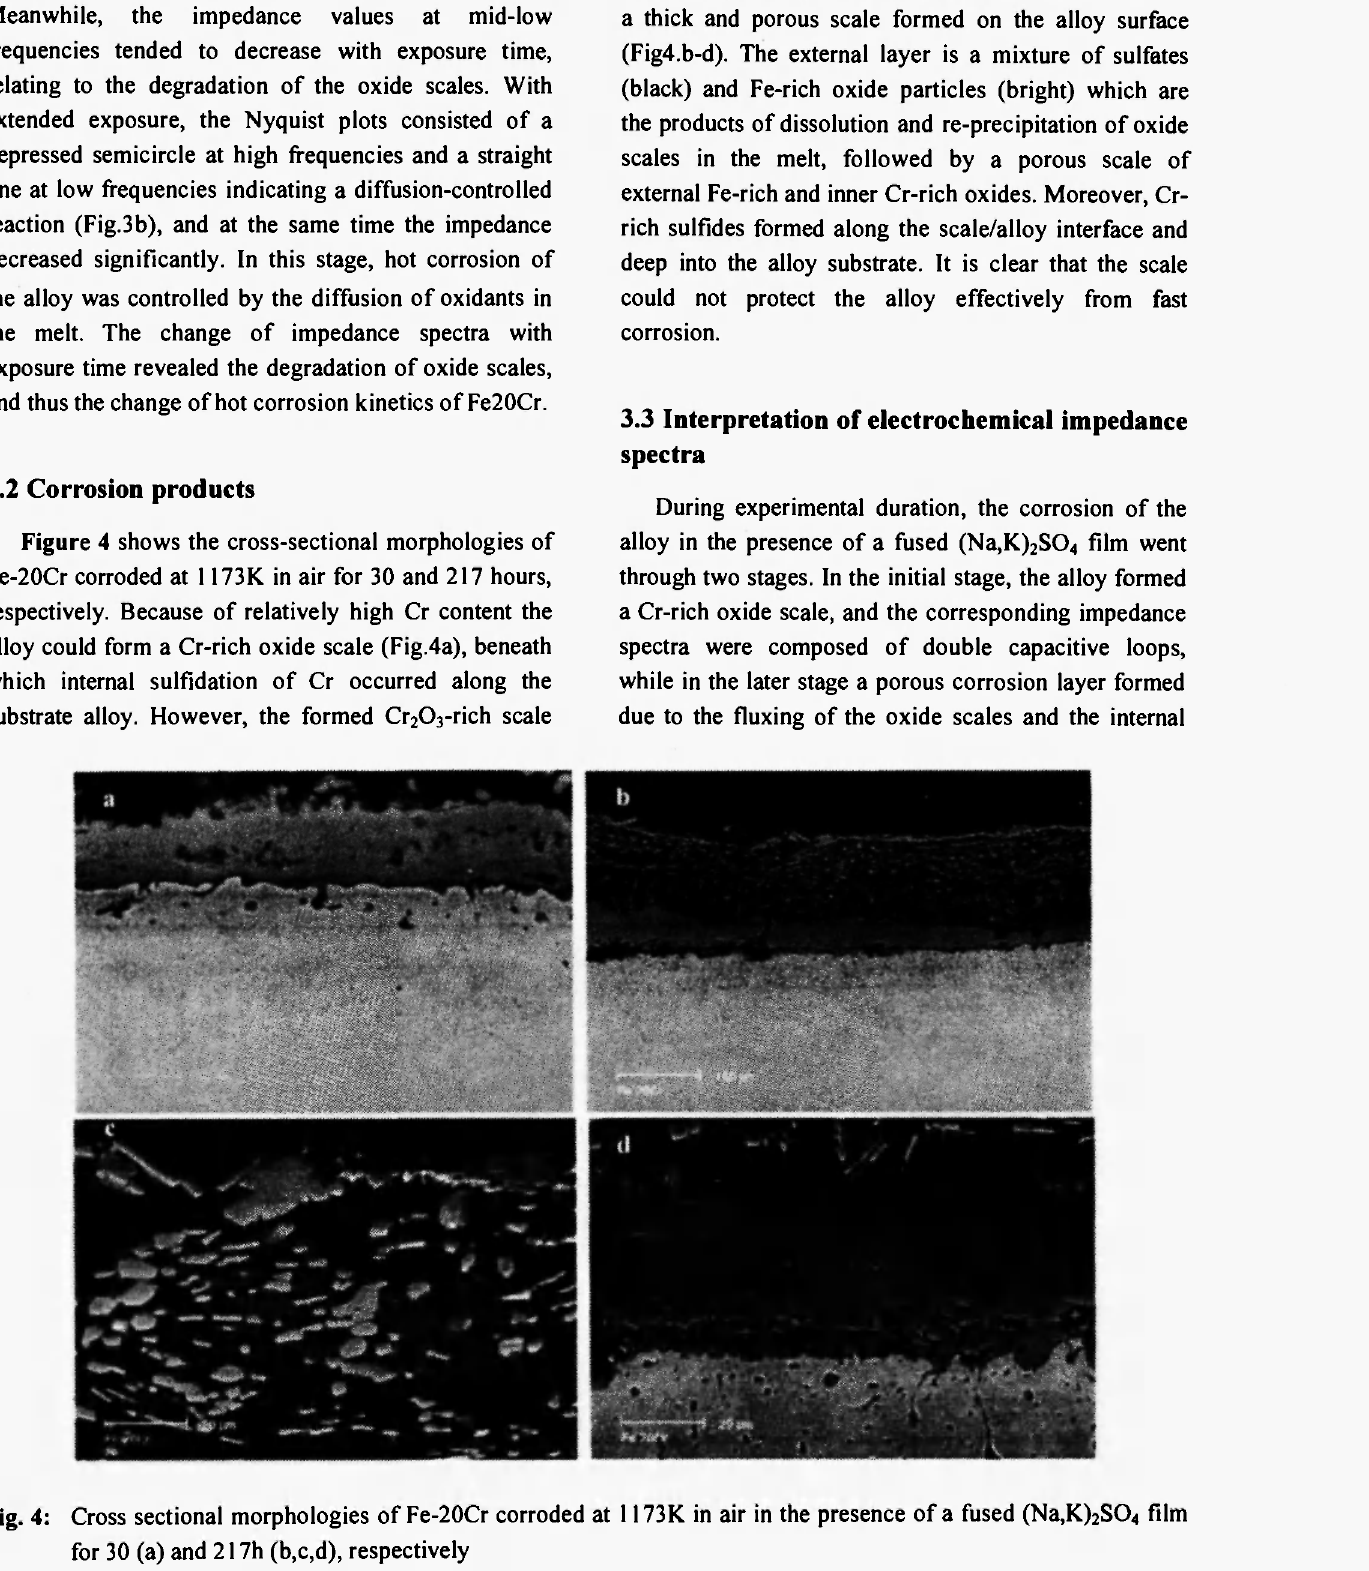
Fig. 4: Cross sectional morphologies of Fe-20Cr corroded at 1173K in air in the presence of a fused (Na,K) 2 S0 4 film for 30 (a) and 217h (b,c,d),